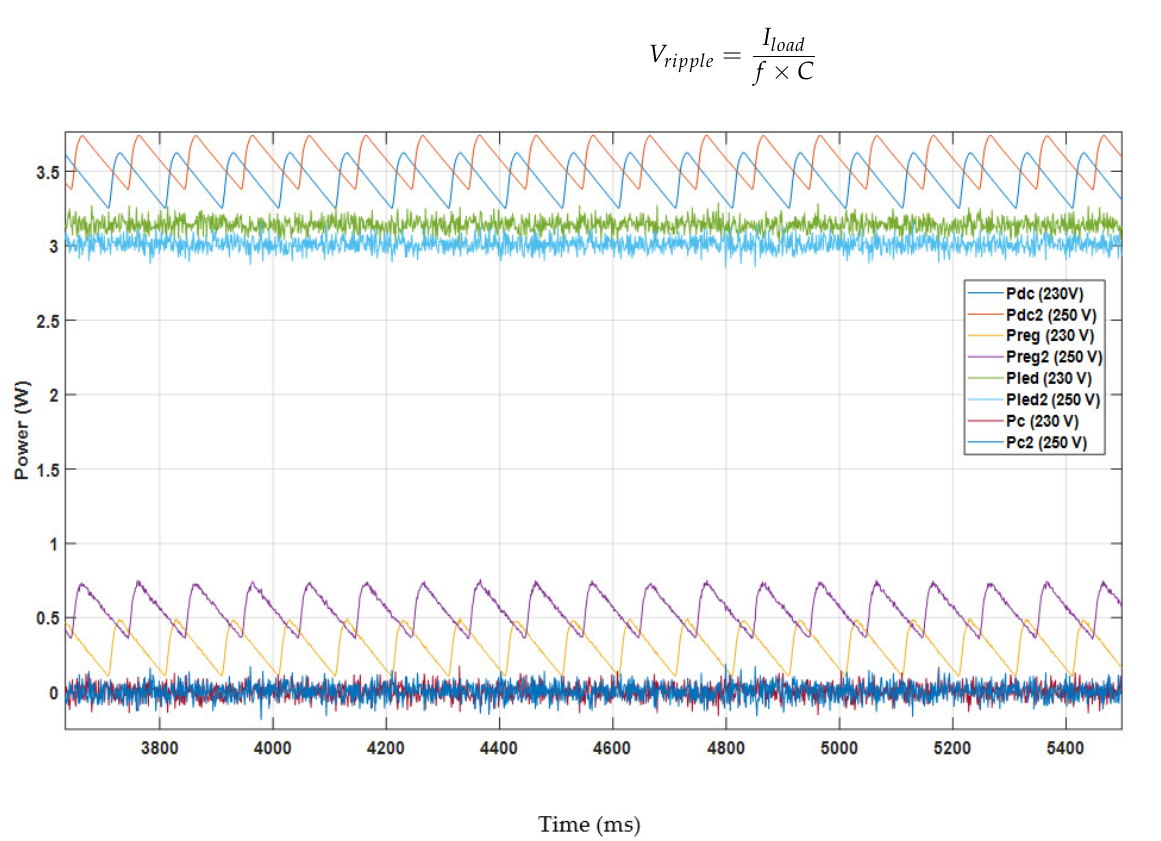
Figure 9. Instantaneous power for different parts of a Type D lamp, for 230 and 250 V voltage on the terminals: (from top to bottom) on the DC side of the inverter (Pdc); at regulator IC (Preg), all LEDs (Pled); the current control circuit; the capacitor (Pc).